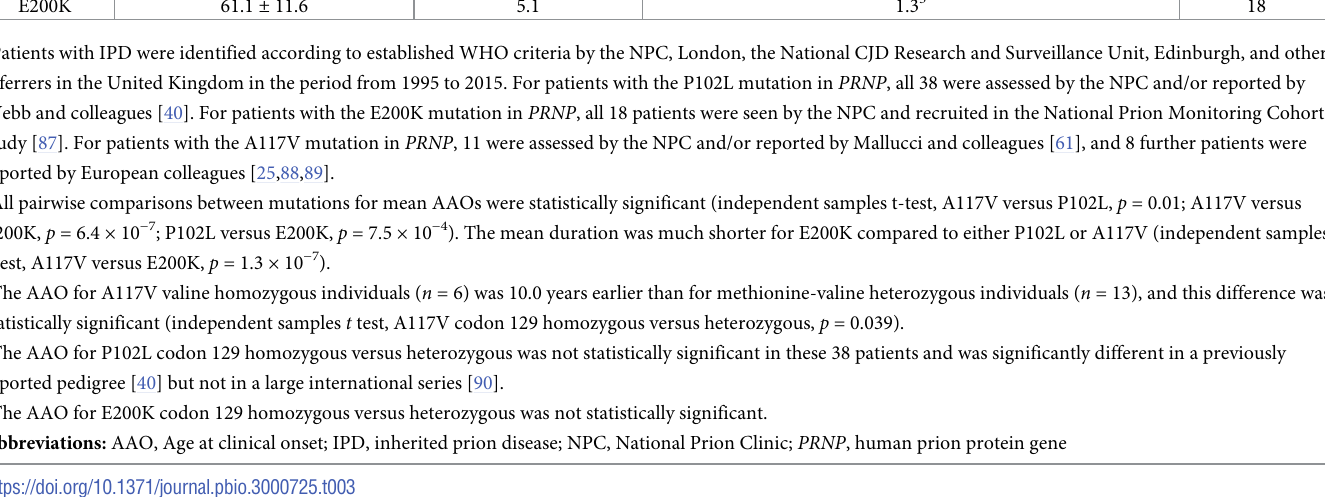
Mean clinical duration Mean difference in AAO between codon 129 homozygotes and (months) heterozygotes